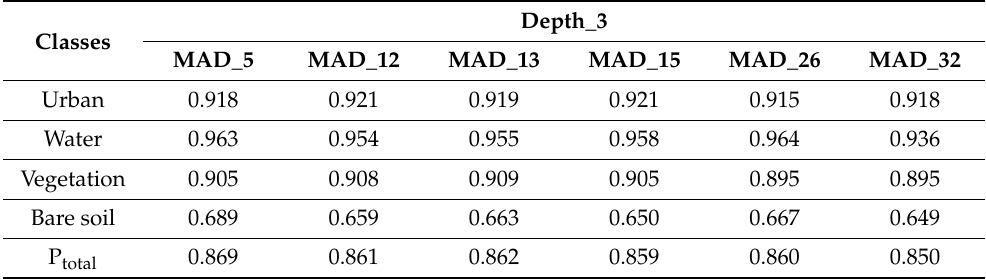
Table 8. Probabilities for classes and total probabilities of correct classification for depth 3 and different MAD.